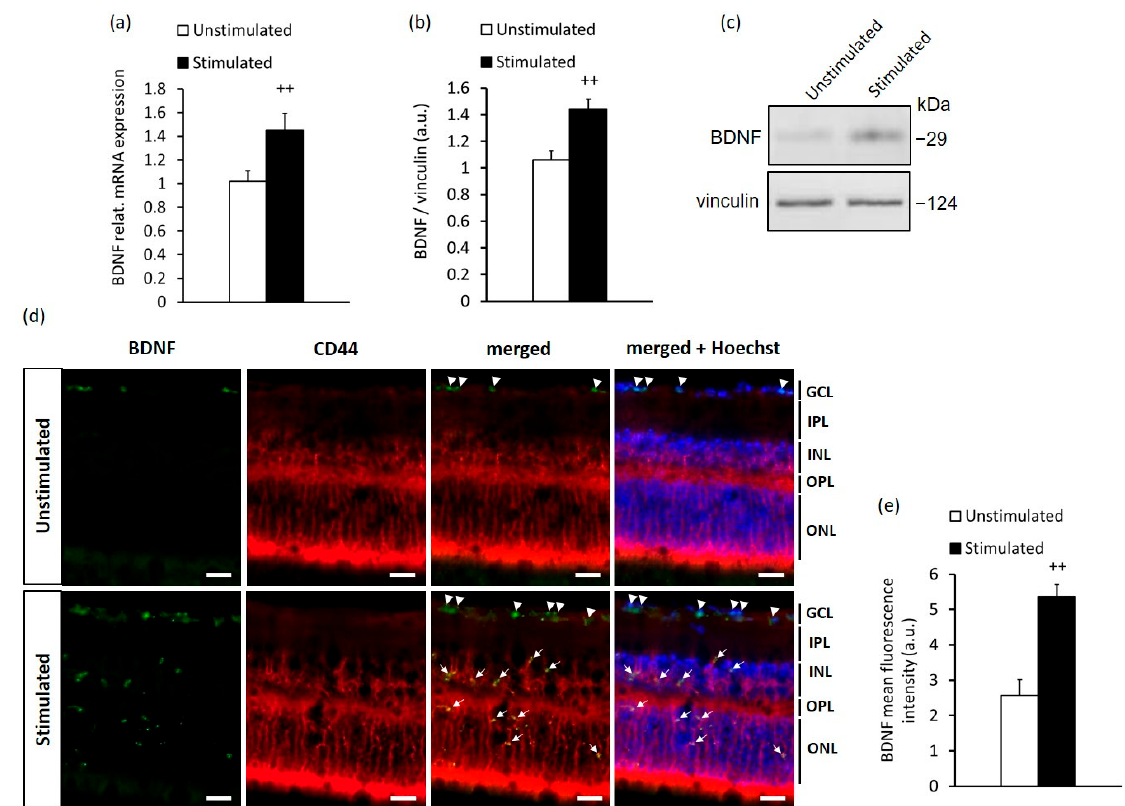
Figure 1. High-contrast stimulation promoted BDNF expression in the adult mouse retina. ( a ) Quantification of relative mRNA and ( b ) protein expression of BDNF in the retina of high-contrast-stimulated and unstimulated mice, and ( c ) representative Western blot images. ( d ) Immunofluorescence of BDNF (green); CD44, a marker of MCs (red); and Hoechst nuclear staining (blue) in the retina from high-contrast-stimulated and unstimulated mice. The arrowheads show BDNF expression in the GCL and the white arrows show the colocalization of BDNF with MCs. The scale bar is 20 µm. GCL, ganglion cell layer; IPL, inner plexiform layer; INL, inner nuclear layer; OPL, outer plexiform layer; ONL, outer nuclear layer. ( e ) Quantification of BDNF immunofluorescence intensity in the retina of stimulated and unstimulated mice. The data are presented as the mean ± SEM of 5 mice per group in each experiment. Difference between the high-contrast-stimulated and unstimulated groups: ++ p < 0.01 (unpaired t -test).